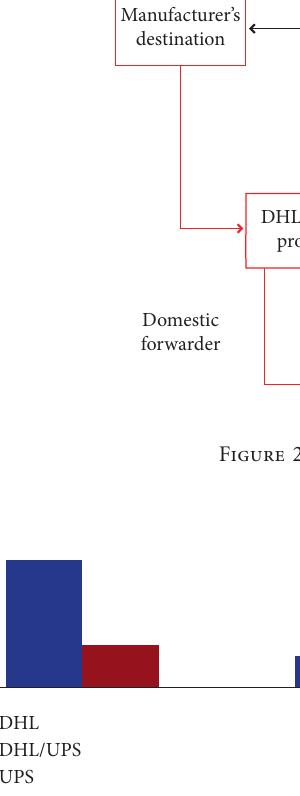
Figure 3: Popular service providers in the current sample exchange practice.